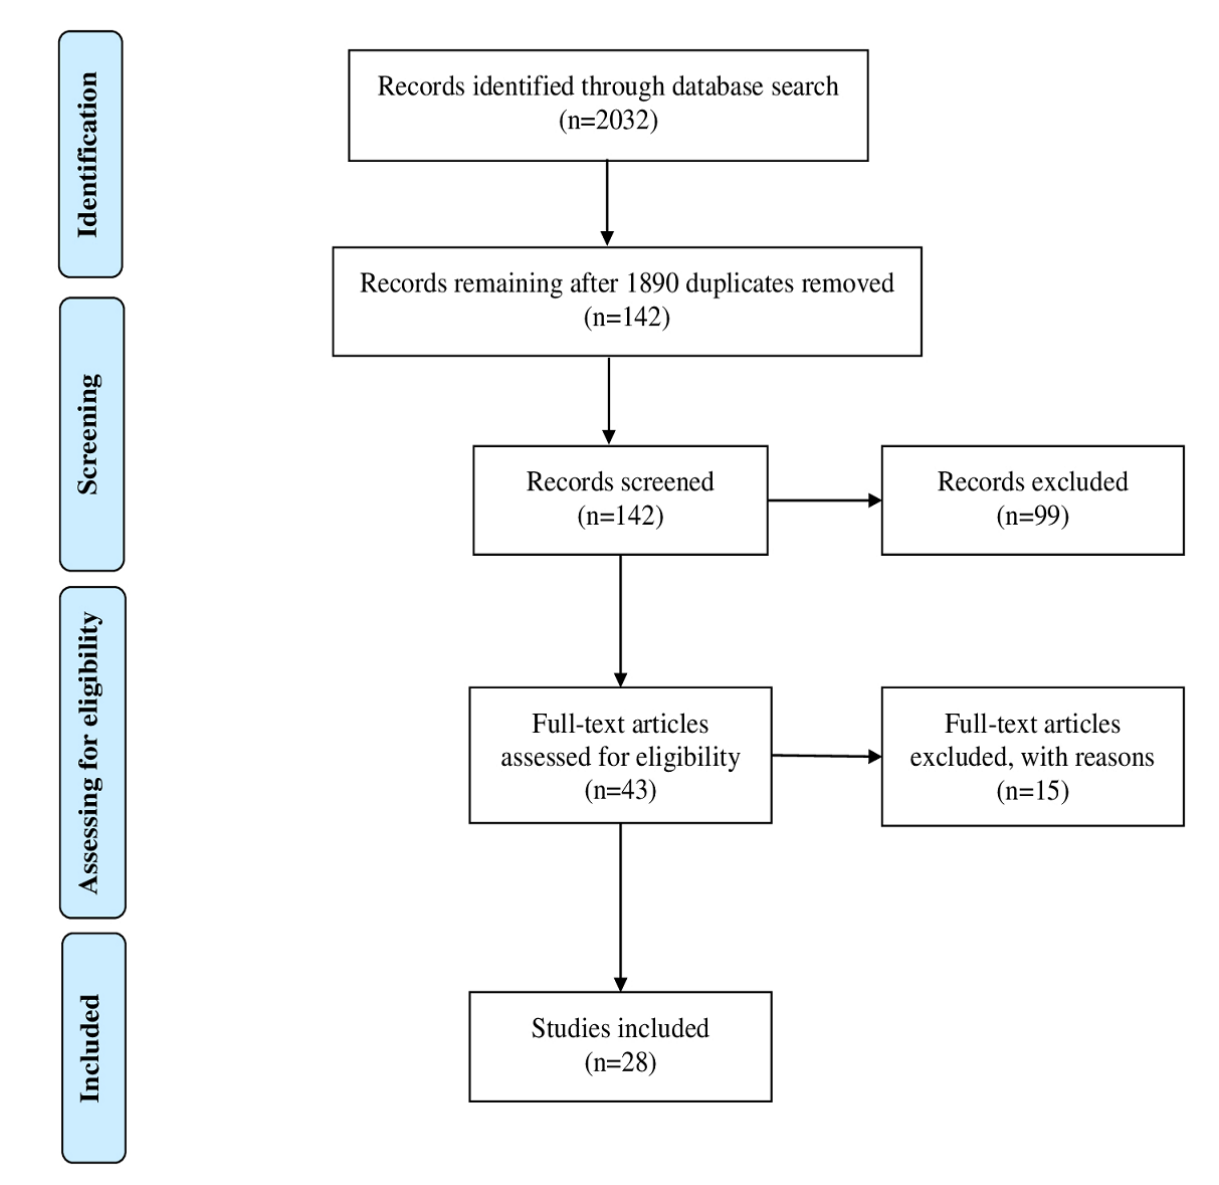
Figure 1. Flow diagram of the search results and the study selection process using the PRISMA